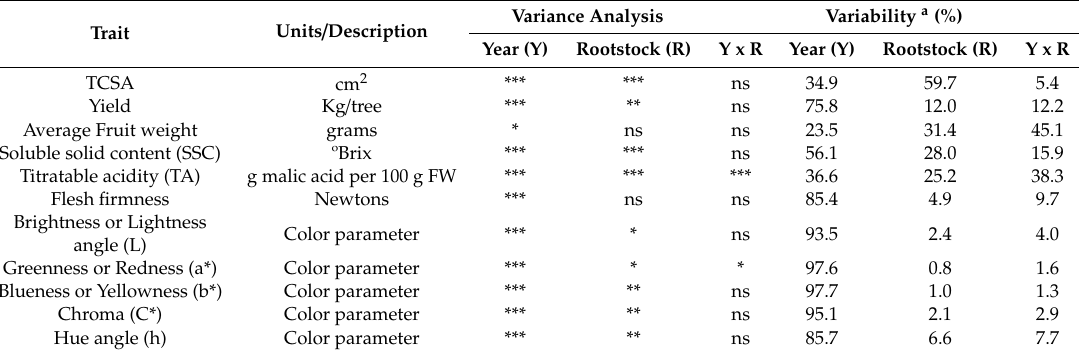
Table 4. Statistical significance of year, rootstock, and their interaction of rootstock on tree performance and fruit quality of “Big Top” budded on 12 rootstocks.